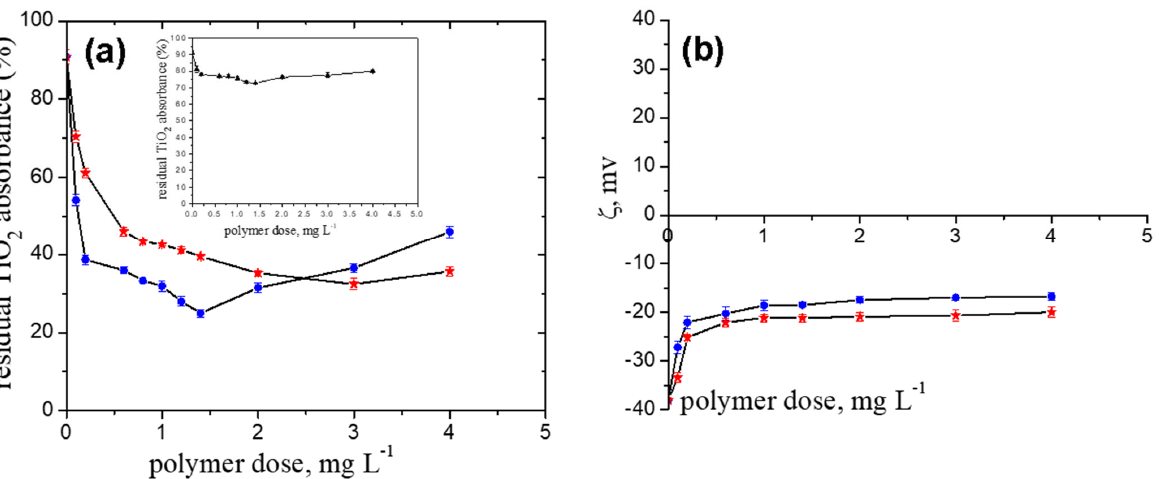
Figure 5. The residual TiO 2 absorbance (%) ( a ) and zeta potential ( b ) dependence on the polymer dose for: TMAP 0.7 –P (circle); TMAP 0.2 –P ; (star); the inset: P (triangle); c ip = 1 g L − 1 , c TiO2 = 0.05 g L − 1 , pH =5, settling time 1200 min.